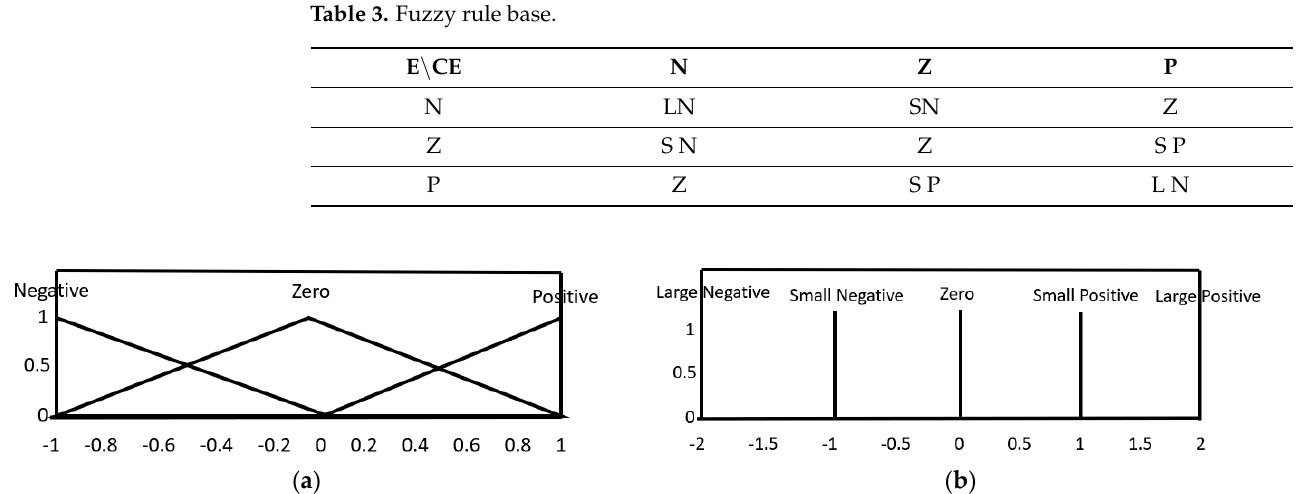
Figure 9. Membership for E and CE ( a ) input membership and ( b ) output membership.